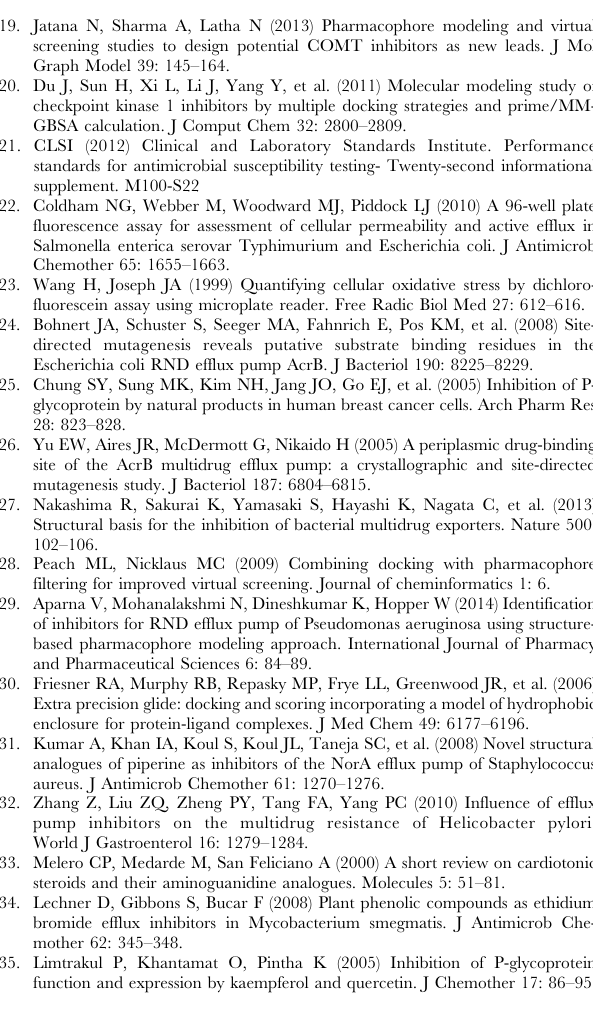
Table S1 Common pharmacophore hypotheses and model of the known efflux substrates of MexB and AcrB efflux